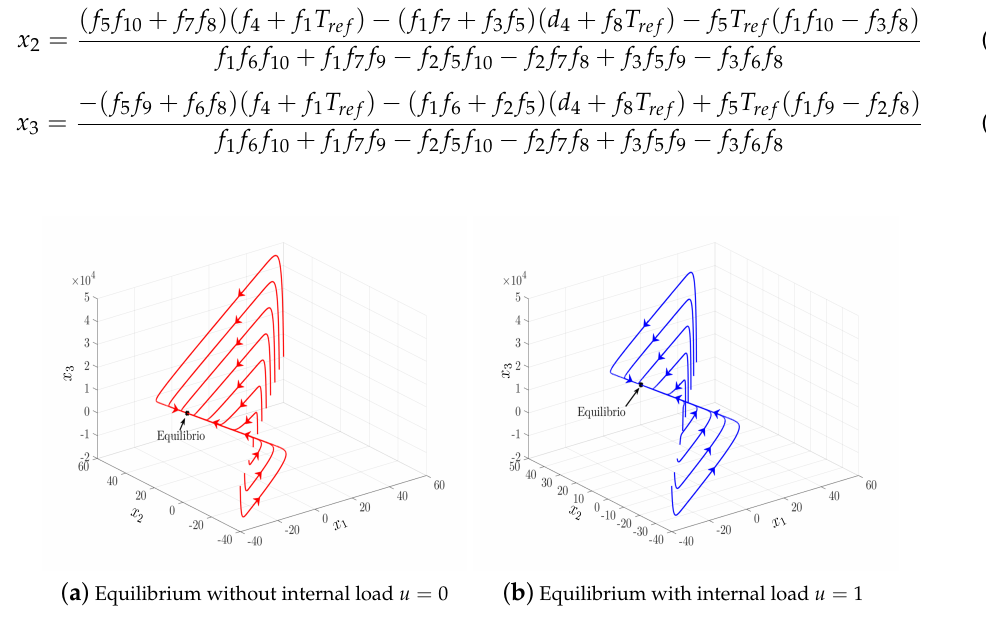
Figure 7. Equilibrium of the geodesic dome with and without internal